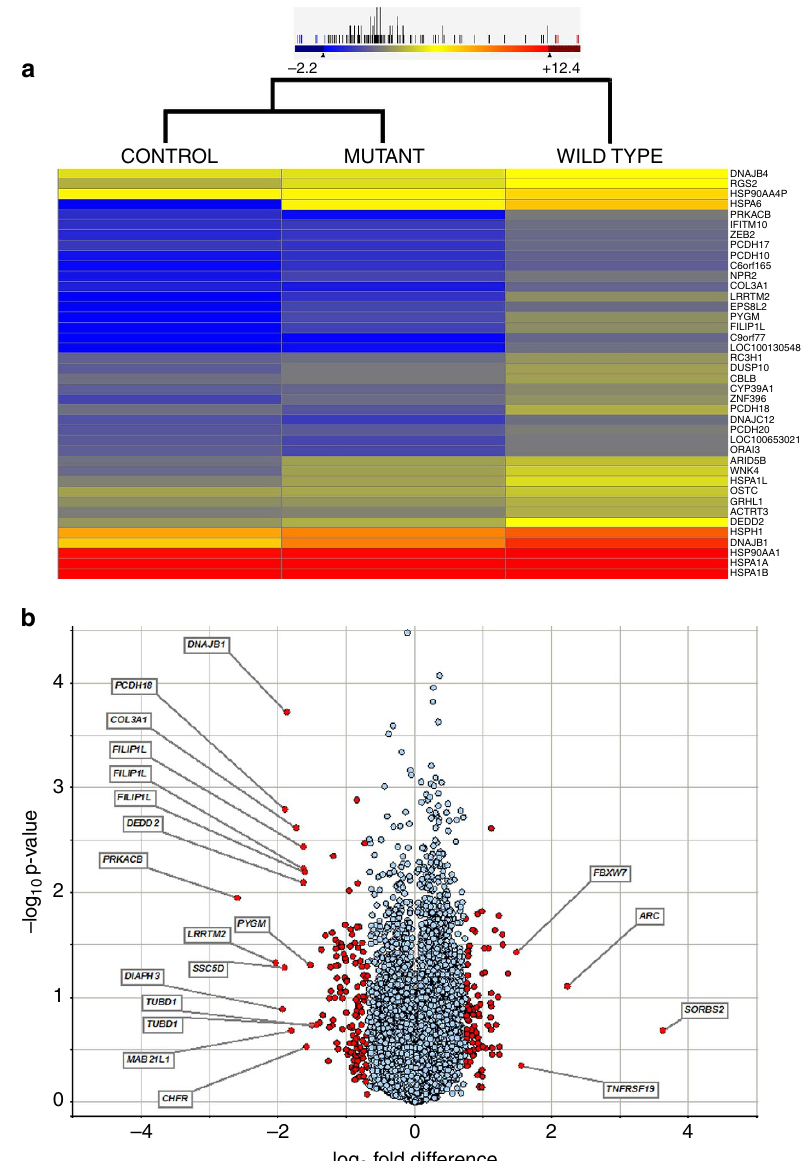
Figure 1 | Illustration of the differentially regulated transcripts in HEK293 cells expressing mutant (p.C240*) FOXE3. ( a ) Clustering of transcripts that are downregulated in cells expressing the mutant FOXE3 . The differentially expressed genes were selected on the basis of stringent criterion ( p -value r 0.05 (Student’s t -test) and Z 1.5-fold change). The colour of each horizontal line represents the expression of mRNA in a given sample, whereas colour scale from blue to red indicates low to high gene expression. ( b ) Volcano plot representation of differentially expressed transcripts and their statistical significance. The fold changes are represented in log 2 scale depicted on the x -axis, whereas the (cid:2) log 10 p -value is depicted on the y -axis (the use of -log values mean that transcripts with greater statistical significance are higher in the plot). The red circles represent genes that show 3 s.d. differential expression, while red circles with gene names represent differentially expressed transcripts at 6